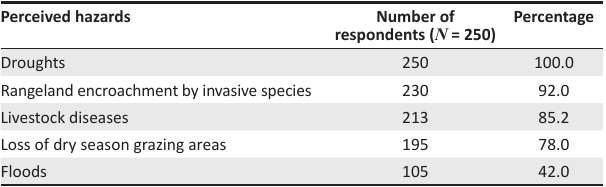
TABLE 1: Hazards perceived by sample households (multiple responses were